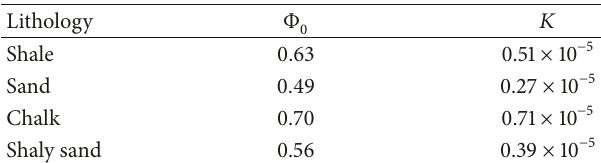
Table 4: Parameters for various lithologies in exponential relation-